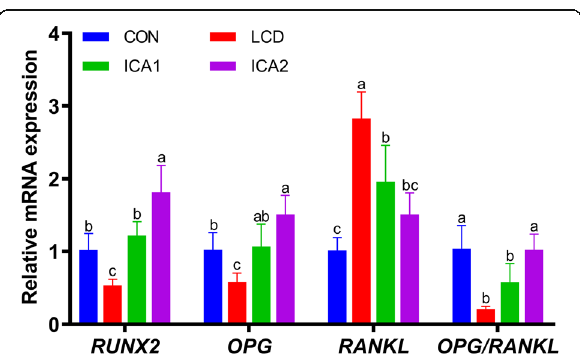
Fig. 5 Effects of ICA supplementation on relative mRNA expression of bone metabolism-related genes. RUNX2 , runt related transcription factor 2. OPG , osteoprotegerin. RANKL , receptor activator of nuclear factor kappa-B ligand. ICA, icariin. CON, basal diet. LCD, low calcium diet. ICA1, low calcium diet supplied with 0.5 g/kg ICA. ICA2, low calcium diet supplied with 2.0 g/kg ICA. Data are presented as the mean ± SD ( n = 6). Means in each column with different alphabetic letters are significantly ( P < 0.05)